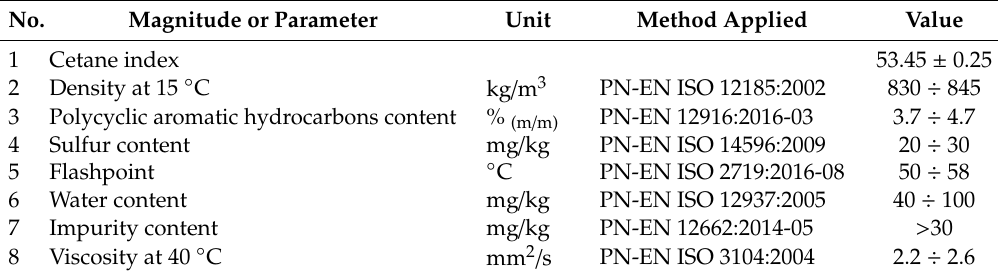
Table 3. Selected properties of the obtained